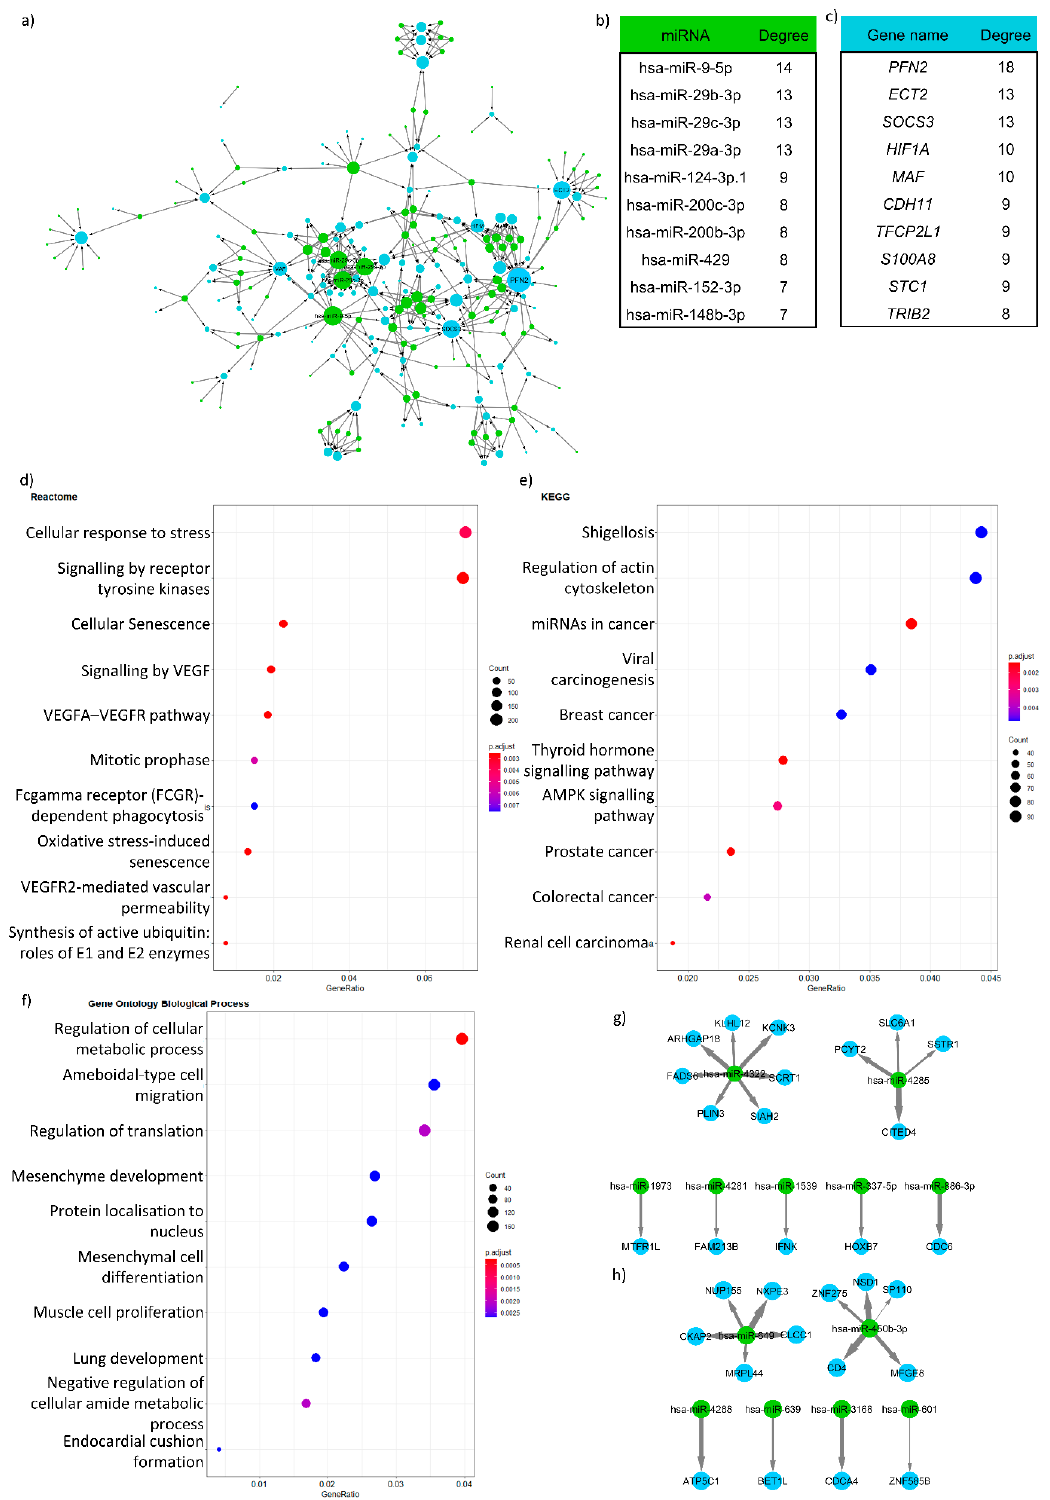
Figure 3. ( a ) miRNA-target gene network using the two types of TargetScan network sources. ( b ) miRNAs regulating the most target genes ( c ) Most regulated differentially expressed genes ( d – f ) Overrepresentation analysis using various ontology sources (Reactome, KEGG, and Gene Ontology biological process) of the CD-specific anti-correlation-based miRNA-target gene network. ( g , h ) Specific miRNA-target gene interactions for healthy controls ( g ) and CD patients ( h ). The weight of the edges corresponds with the